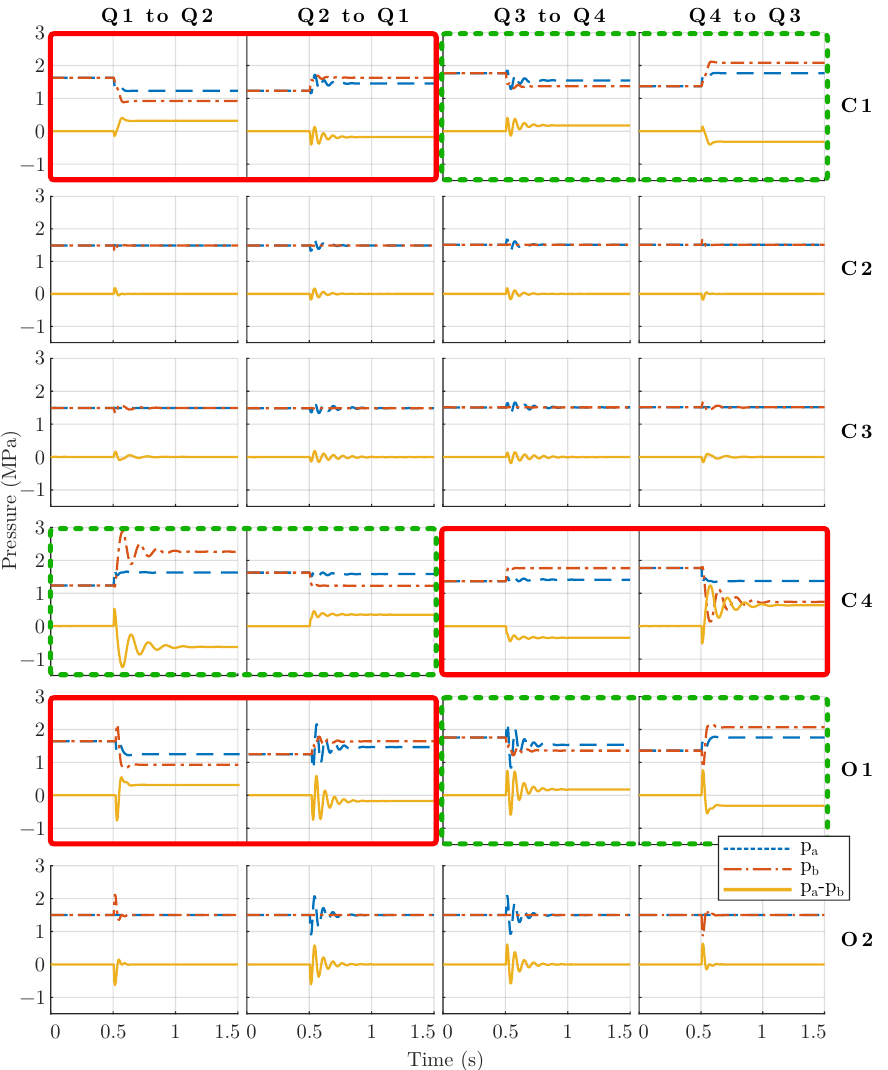
Figure 14. Same as Figure 13, but with slow motor